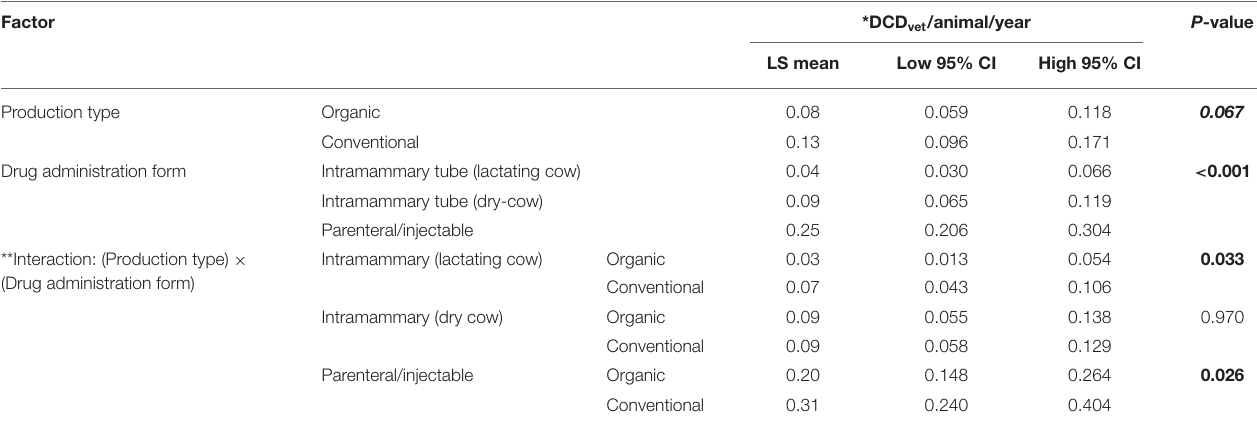
TABLE 4 | Associations between production type and drug administration form [least-square (LS) means, 95% confidence interval (CI)] and antimicrobial use (obtained from BIN data) measured as the number of defined courses animal/year (DCD vet /animal/year) and as estimated in a linear mixed model, in a sample of 60 (30 organic and 30 conventional) Swedish dairy